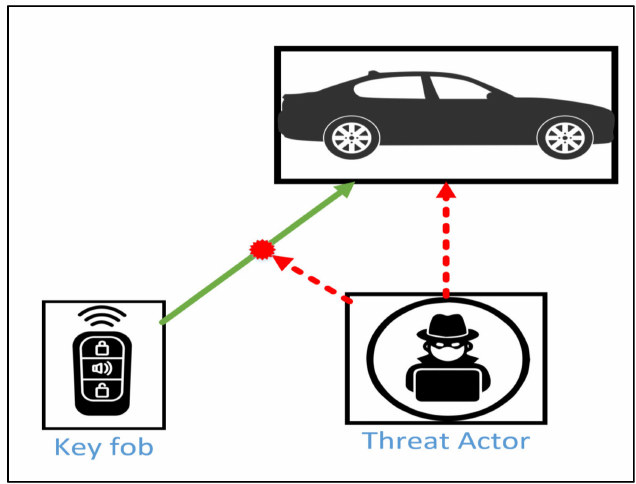
Figure 1. Replay Attack Targeting keyless